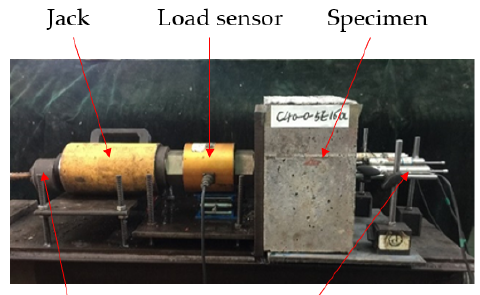
Figure 3. Device for central pull-out test.